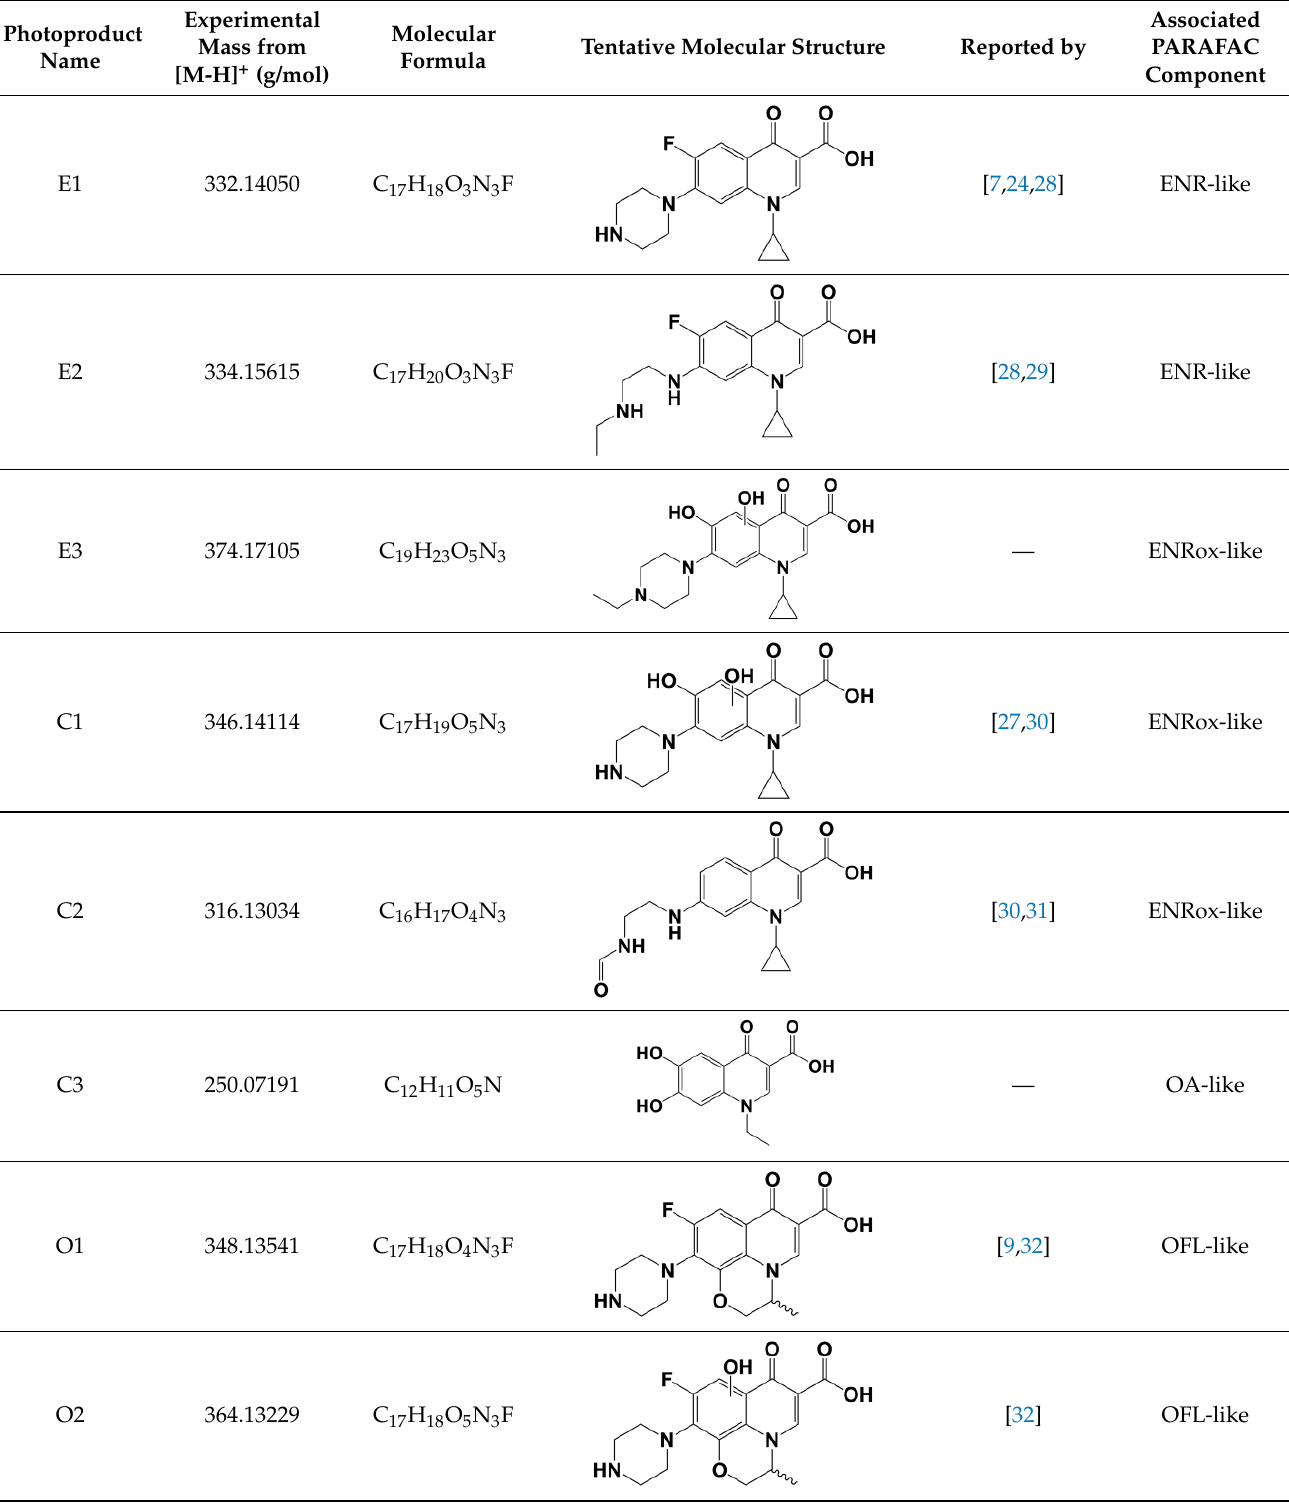
Figure 5. Photoproduct formation during photolysis of 12.5 µM standard solutions of: ( A ) enroflox- acin (formation kinetics of E1-E3), ( B ) ciprofloxacin (formation kinetics of C1-C3), and ( C ) ofloxacin (formation kinetics of O1 and O2). The signal intensity for the photoproducts found from oxolinic acid and flumequine photolysis were negligible in both cases, and results are not shown. Table 1. EEM-PARAFAC correlation with UHPLC-HRMS results. The transformation products were named with a first letter associated to the compound which were generated, and a number linked to the oxidation degree: E1 – E3, from Enrofloxacin; C1 – C3, from Ciprofloxacin; O1 and O2, from Ofloxacin; F1, from Flumequine; and Oa1, from Oxolinic acid.